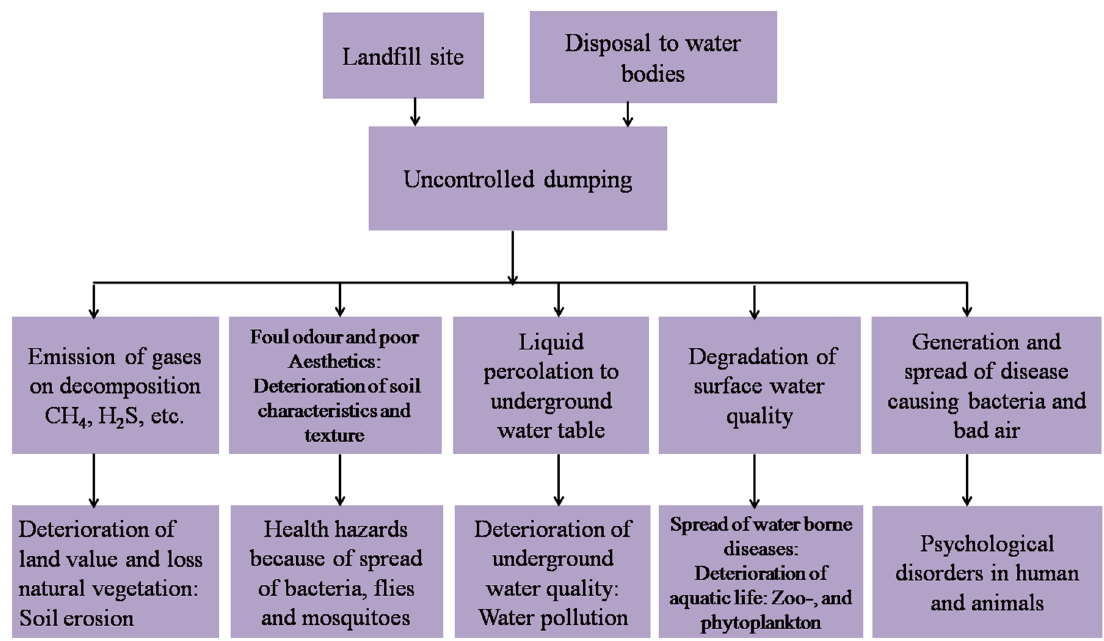
Figure 1. Conventional methods of waste removal from citrus processing plants and deteriorating effects to the environment.